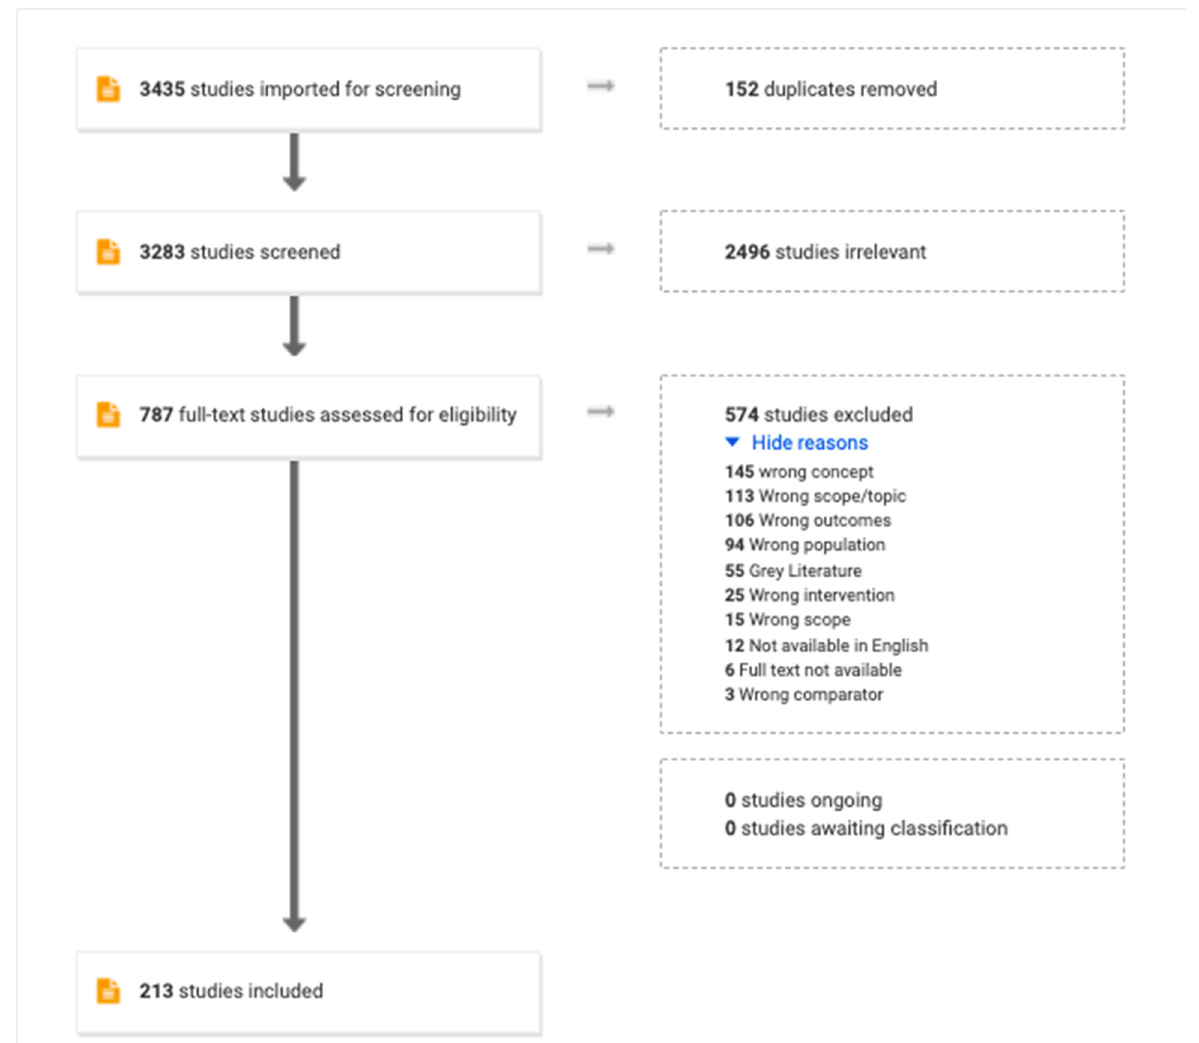
Figure 1. PRISMA Flow Diagram.